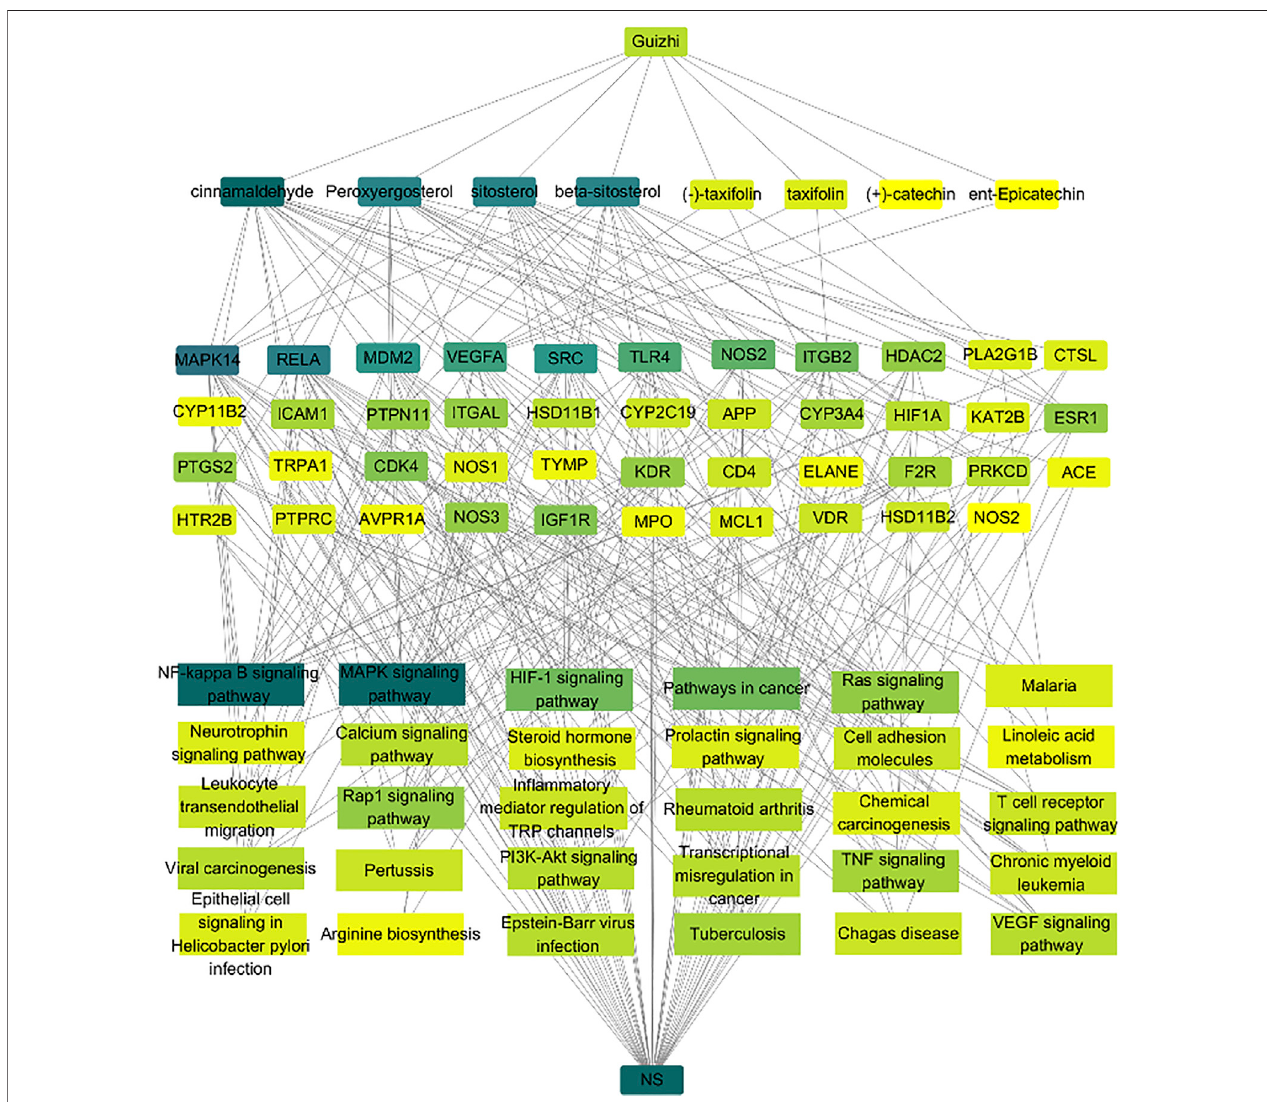
FIGURE 5 | Network analysis of the association among the active compounds, key targets and signaling pathways. Here, we collected the eight active compounds, top 30KEGG pathways, and buildtheirlinks with theircorrespondingtargets. Thecolor represented the degreevalue,and itchangesfrom yellow togreen indicated the greater degree value. We found that cinnamaldehyde is the top one active compound with the highest degree value, and the NF-Kappa B and MAPK signaling pathways have more connection with the key targets.